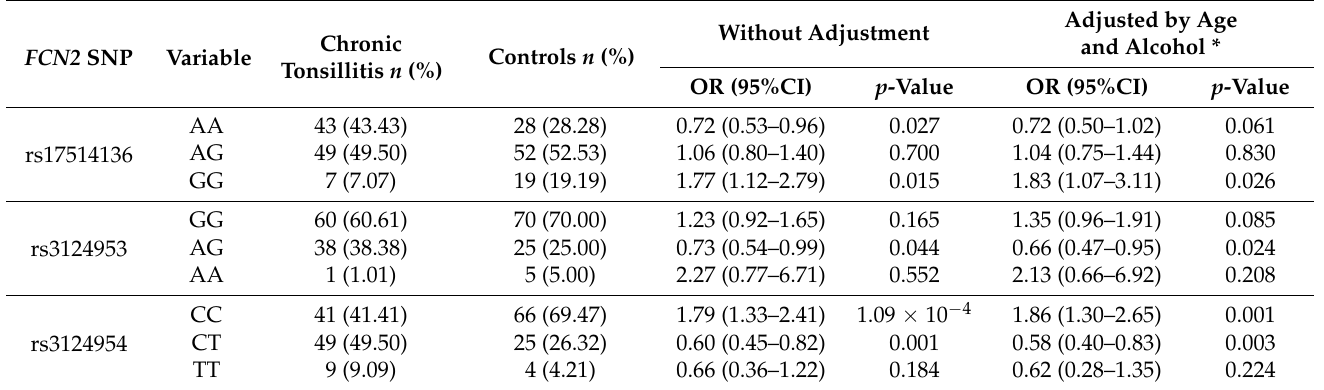
Table 4. Frequency of FCN2 genotypes in patients with chronic tonsillitis and controls.